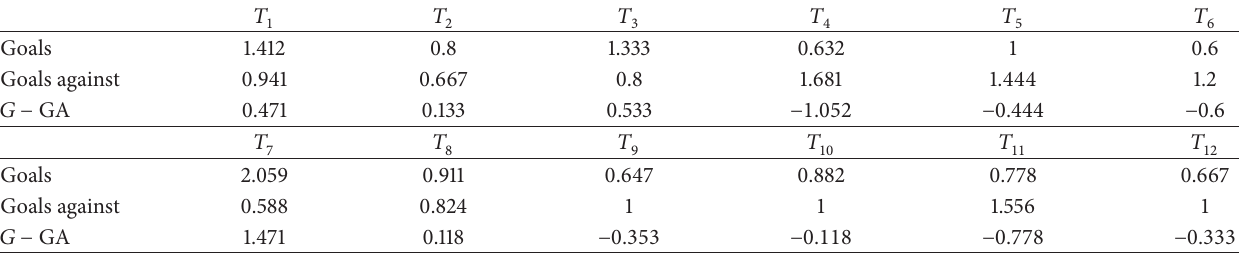
Table 3: Numbers of goals, goals against, and their difference.